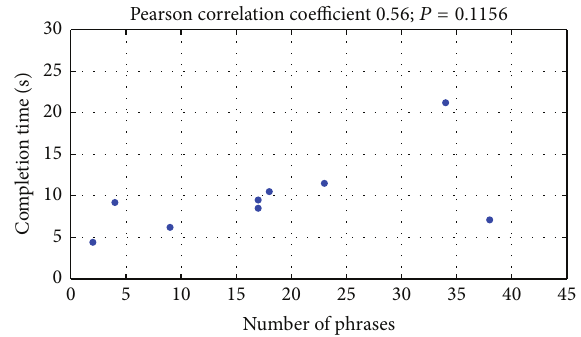
Figure 7: Completion time versus number of verbal phrases